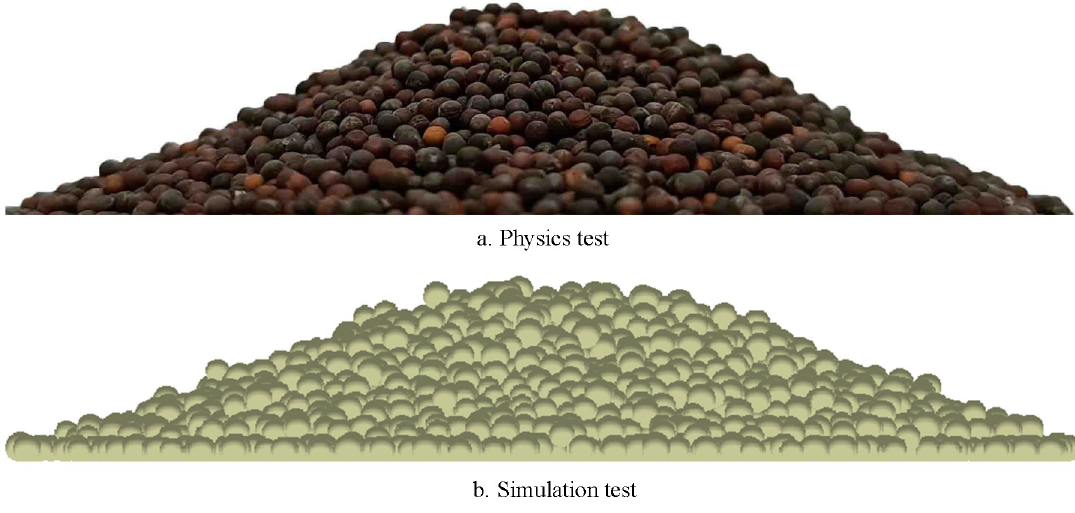
Fig 7. Comparison of physical test and simulation